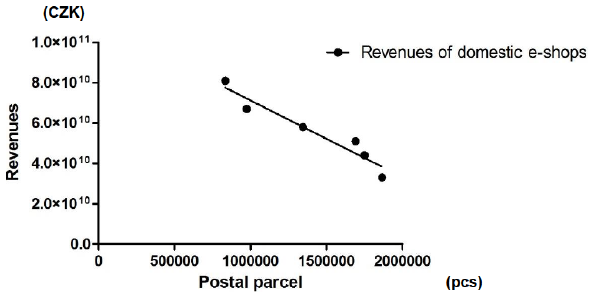
Figure 6: Dependence of postal parcel on revenues of domestic